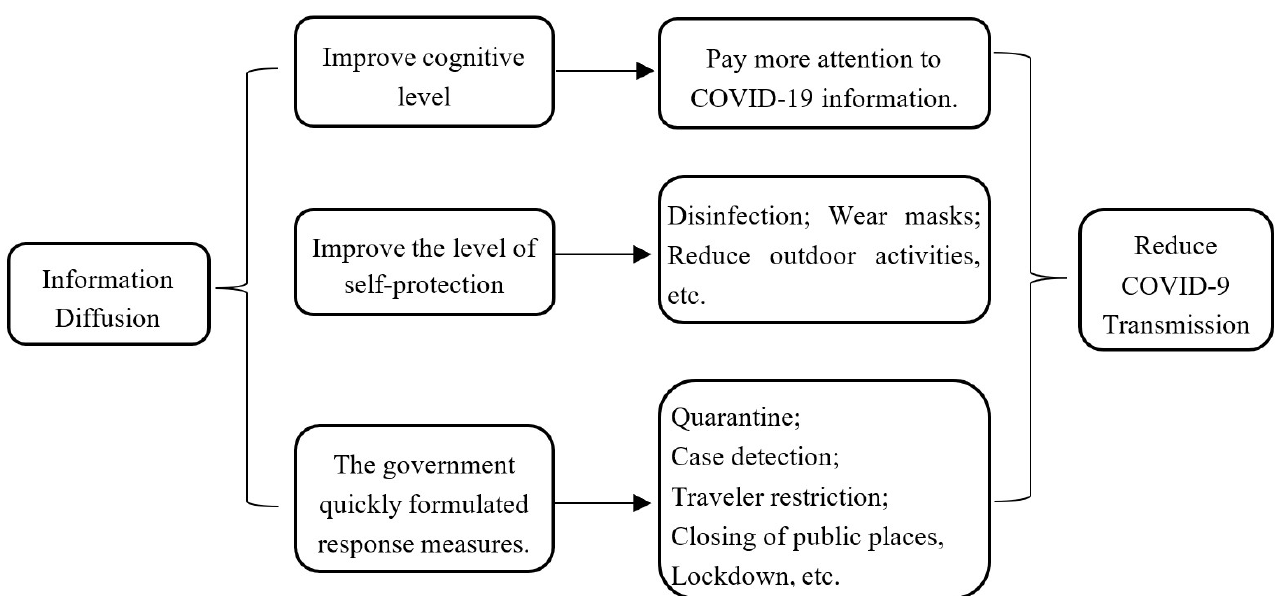
Figure 1. Analysis of the mechanism of information diffusion to reduce COVID-19 transmission.